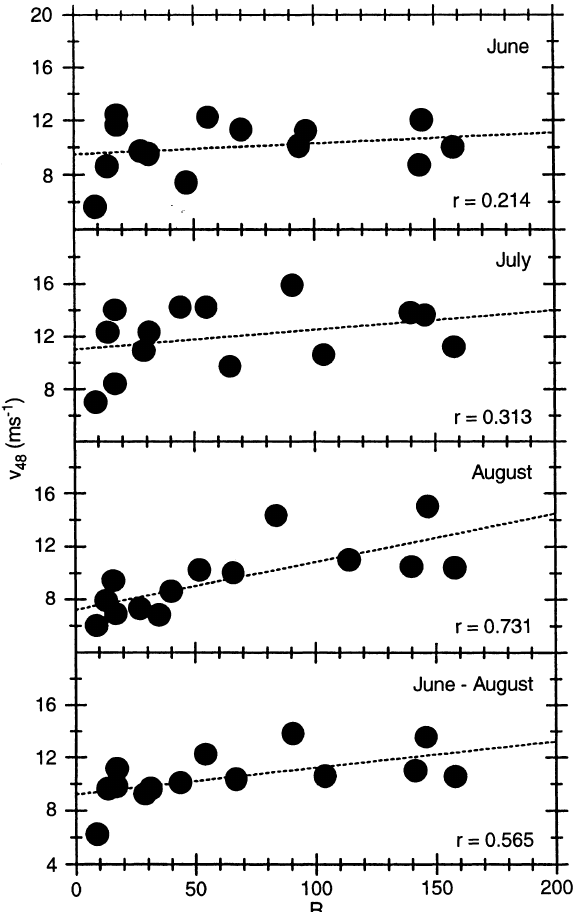
Fig. 8. Correlation between the monthly mean 2-day amplitude V and the 13-monthly smoothed sunspot number R for the months June–August, from Collm measurements of the years 1983–1996. The respective correlation coe(cid:129)cients r are